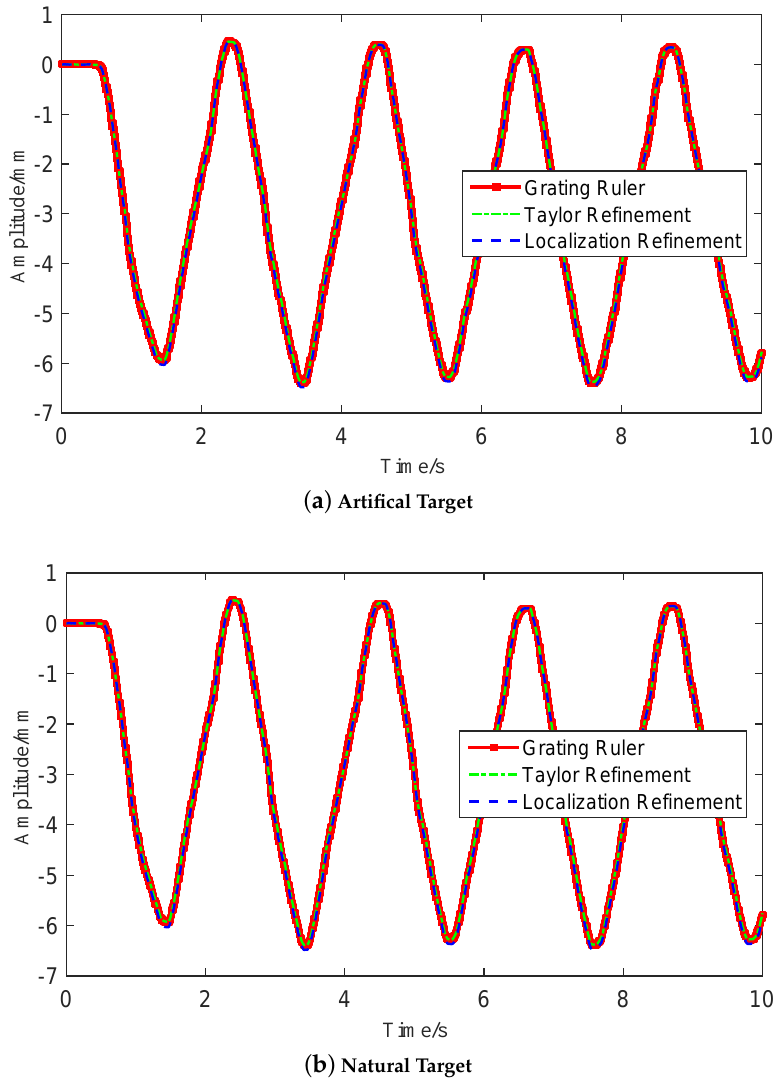
Figure 10. Measurement comparisons between the grating ruler sensor and the vision-based sensor: ( a ) results using an artificial target; ( b ) results using a natural structure